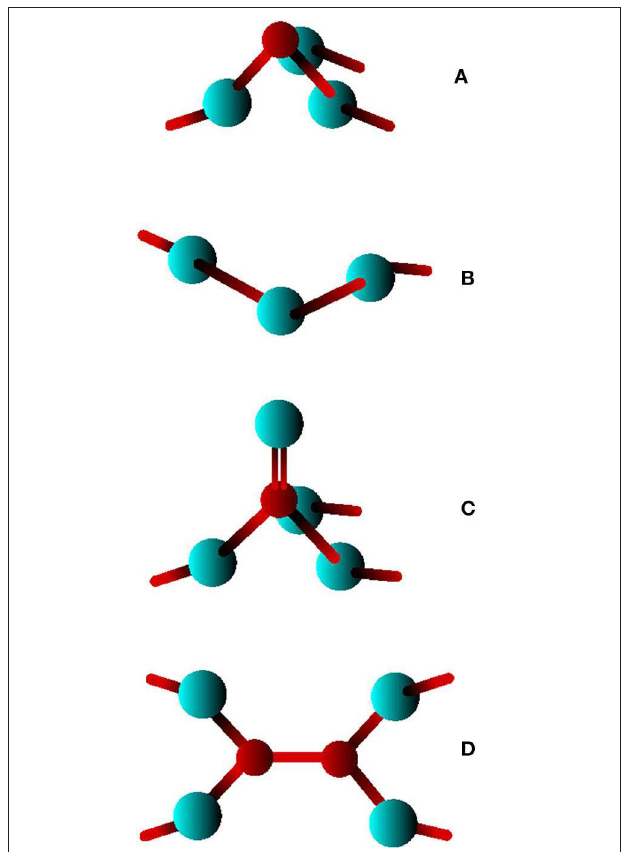
FIGURE 1 | Possible local structures in amorphous As 2 Se 3 : (A) a pyramidal AsSe 3 / 2 (PYR), (B) a Se chain-like fragment, (C) a quasitetrahedral Se 3 / 2 As=Se unit, (D) a homopolar As-As